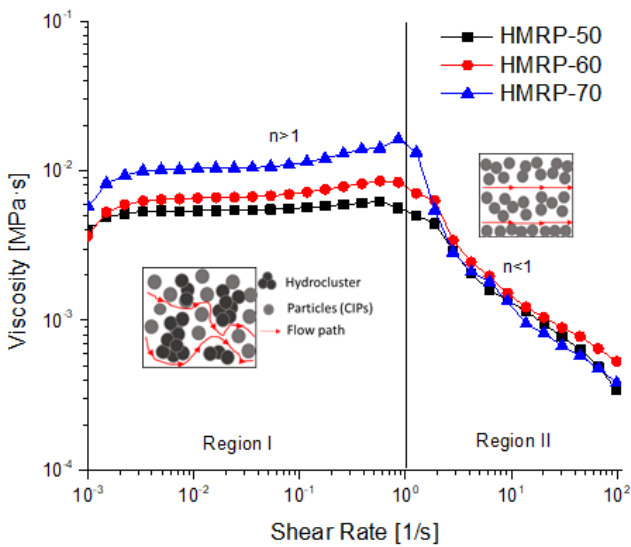
Figure 2. The viscosity versus shear rate for PVA HMRP samples with different CIP contents.